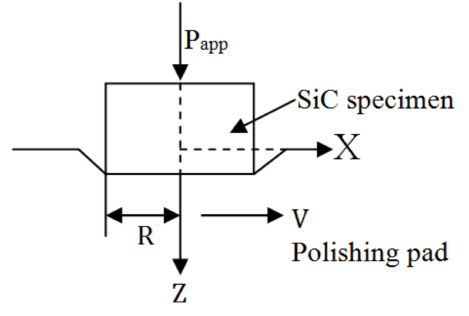
Figure 2. Illustration of the rigid body contact